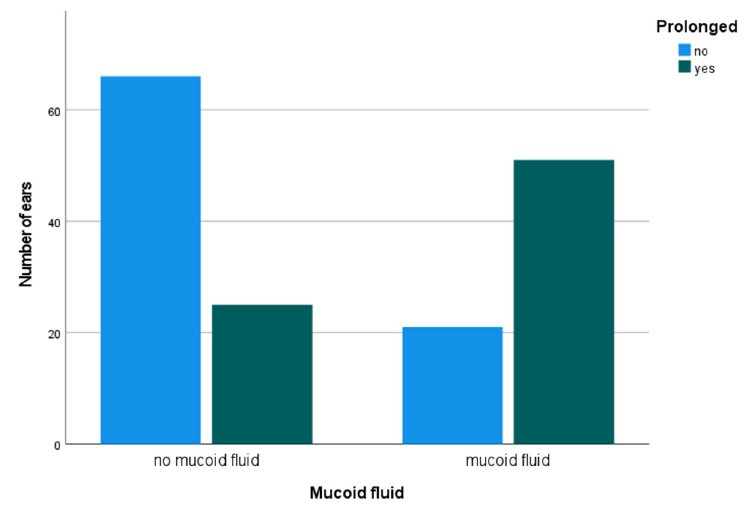
Figure 3. Prolonged intraoperative auditory brainstem response latencies of wave I across 80-, 90-, and 100-dB SPL comparing 153 ears with and without mucoid fluid (at 80 dB prolonged males > 1.95 ms and females > 1.88 ms; at 90 and 100 dB prolonged > 1.90 ms).